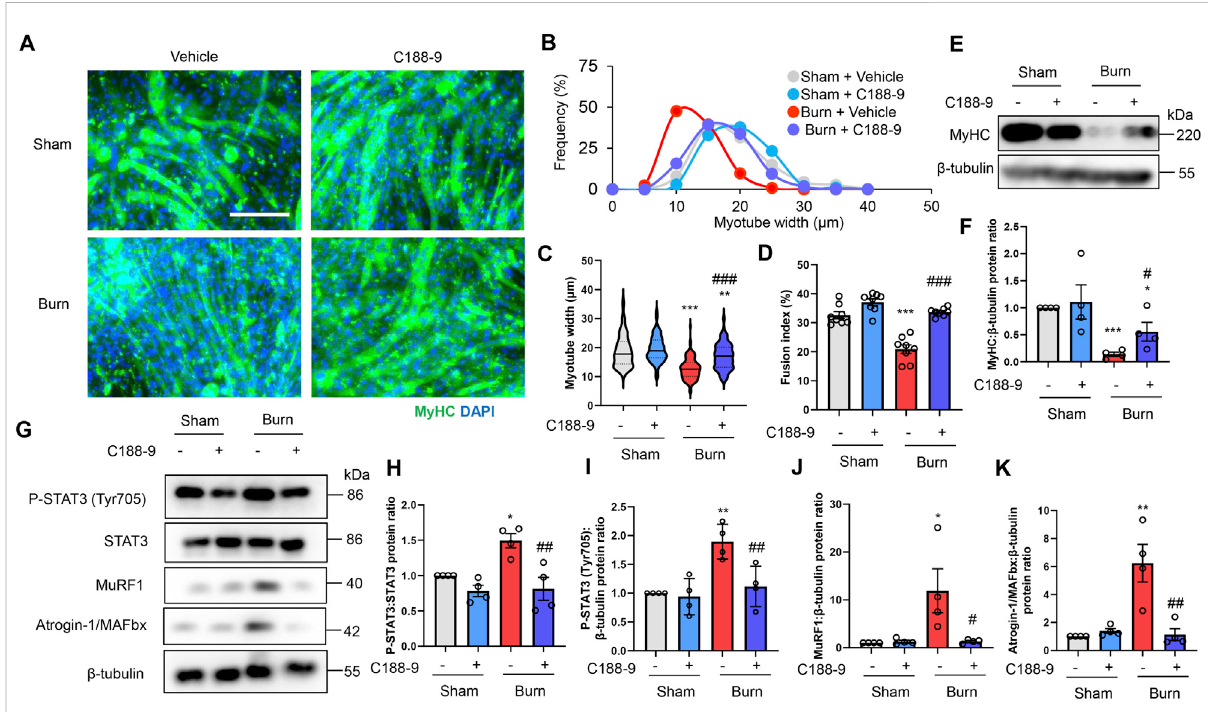
FIGURE 6 C188-9 reduces proteolytic pathway activation and atrophy of C2C12 myotubes induced by plasma from mice with thermal burn injury. C2C12 myotubes were treated with vehicle (0.1% vol/vol DMSO) or C188-9 (10 µM) and then with plasma collected from mice with third-degree burnsorsham-burninjuries(5%vol/vol)1 hlater.Representativeimmuno fl uorescencestainingofMyHC inC2C12 myotubes (A) treatedwithvehicle or C188-9, and with plasma from burn or sham-burn mice for 48 h. Scale bar = 100 µm. Distribution of myotube widths (B) , violin plot of myotube width (C) , and fusion index (D) . N = 103 – 127/group. The continuous lines and dotted lines within the violin plot indicate the median and quartiles, respectively. The fusion index was calculated from eight randomly selected fi elds. Western blot analysis (E) and quanti fi cation (F) of MyHC expression in C2C12 myotubes treated for 48 h with vehicle or C188-9, and with plasma from burn or sham-burn mice. Data in (F) were normalized to β -tubulinproteinlevels,andtheratioinsham-vehiclecellswassetas1.N=4/group.Westernblotanalysis (G) andquanti fi cationofP-STAT3 (H,I) , MuRF1 (J) , and Atrogin-I/MAFbx (K) in C2C12 myotubes treated with vehicle, C188-9, and plasma from burn or sham-burn mice for 24 h. Data were normalized to STAT3 protein levels and β -tubulin protein levels, respectively, and the ratio in sham-vehicle cells was set as 1. N = 4/group. For all panels, data are presented as the mean ± s.e.m. *** p < 0.001, ** p < 0.01, * p < 0.05 vs. sham-vehicle cells: ### p < 0.001, ## p < 0.01, # p < 0.05 vs. sham-burn cells. P-values were derived from one-way ANOVA followed by Tukey ’ s honest signi fi cant difference